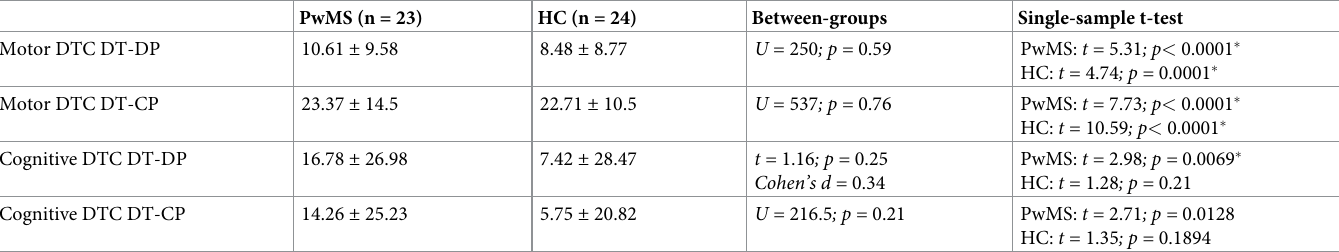
Relationship between CMI measures & symptomatic scales Direct DT scores. Concerning the symptomatic assessment, significant negative correla- tions were revealed in HC between BDI-II and the distance walked in all conditions (ST: rho = -0.41, p = 0.047; DT-DP: rho = -0.52, p = 0.009; DT-CP: rho = -0.48, p = 0.016), whereas no sig- nificant correlations were found between this test and DT parameters in pwMS ( p > 0.05 ) . On Table 5. Comparisons of DTC scores between pwMS and HC (mean ± SD) and contrasts against reference constant (zero value). PwMS (n = 23) HC (n =